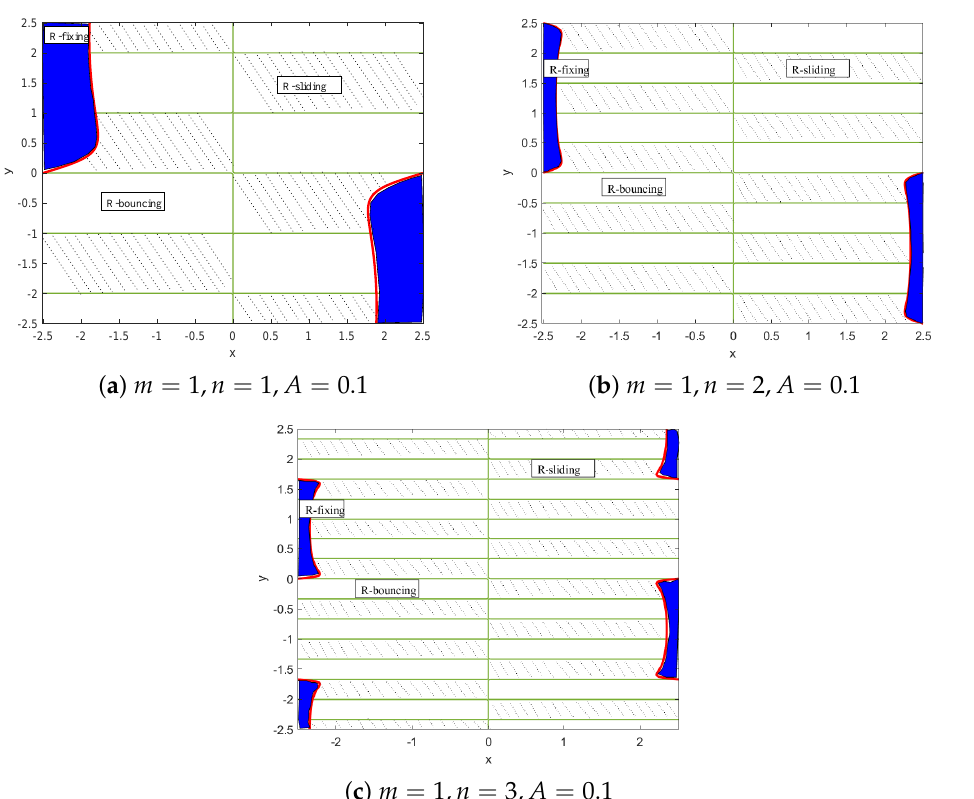
Figure 3. Particle motion modes distribution results of the first three vibration modes with A =